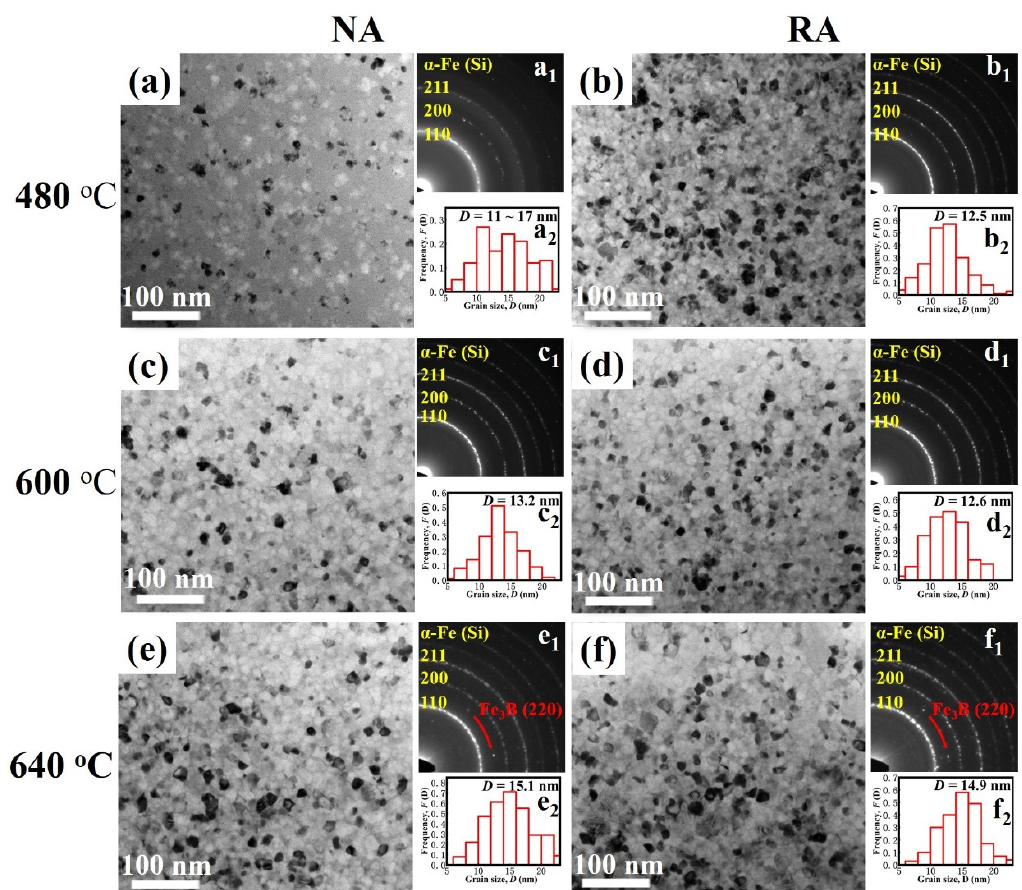
Figure 5. TEM bright-field images, SAED patterns, and grain size distribution of Mn2 annealed at 480, 600, and 640 °C via ( a , c , e ) NA and ( b , d , f ) RA, respectively.